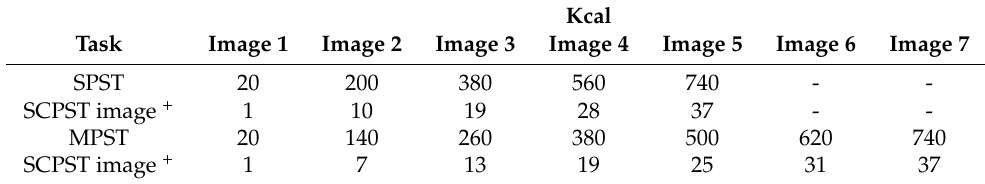
Table 1. Corresponding kcal portions presented as images to participants in the SPST and